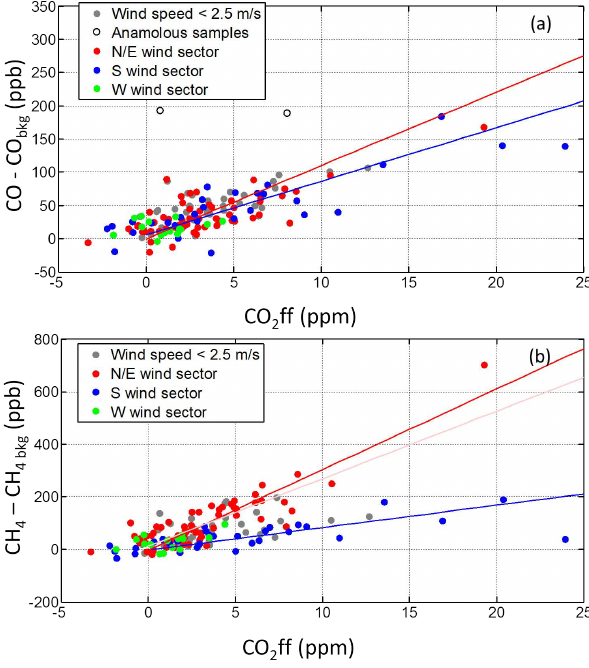
Fig. 4. Correlation plots of CO (a) and CH 4 (b) enhancements (with respect to background observations) with CO 2 ff. Data are sepa- rated into three wind sectors (north and east: red; south: blue; and west: green), except in cases where average wind speeds were be- low 2.5ms − 1 over the 30min prior to sampling. Best-fit lines are shown for the N/E and S wind sectors (correlation coefficients are given in Table 1). In (a) , two points are shown as open circles which are omitted from our analysis (see Sect. 2.5). In (b) , a second best- fit line (light red) is shown for the N/E data, but excludes the highest CO 2 ff